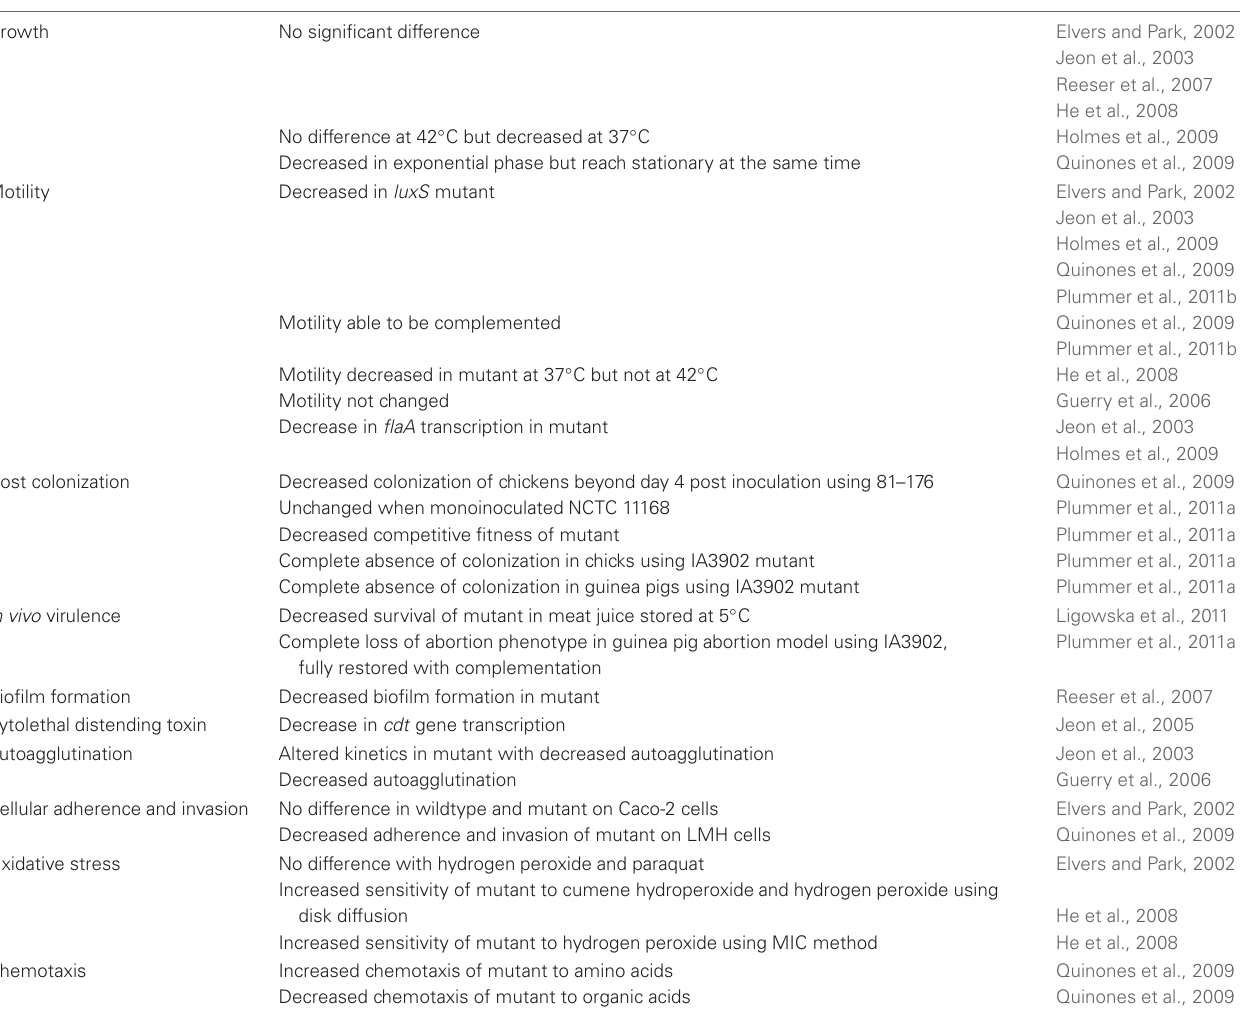
Table 1 | Campylobacter jejuni phenotypes associated with mutagenesis of